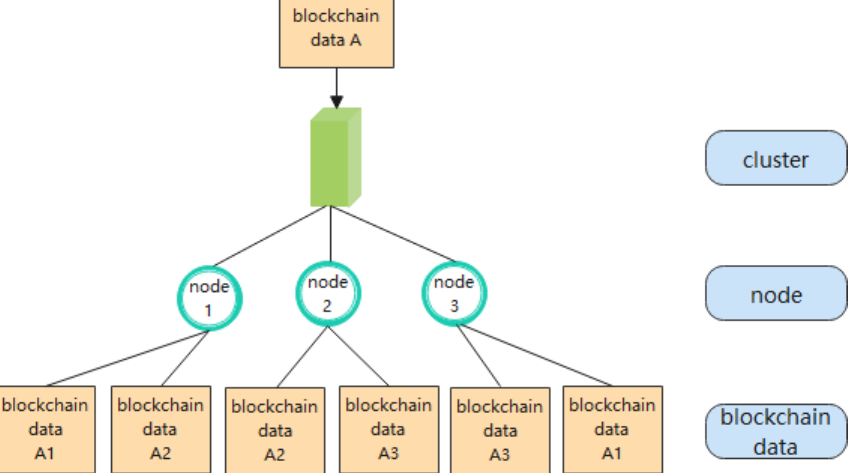
Figure 3. Single cluster data storage structure.